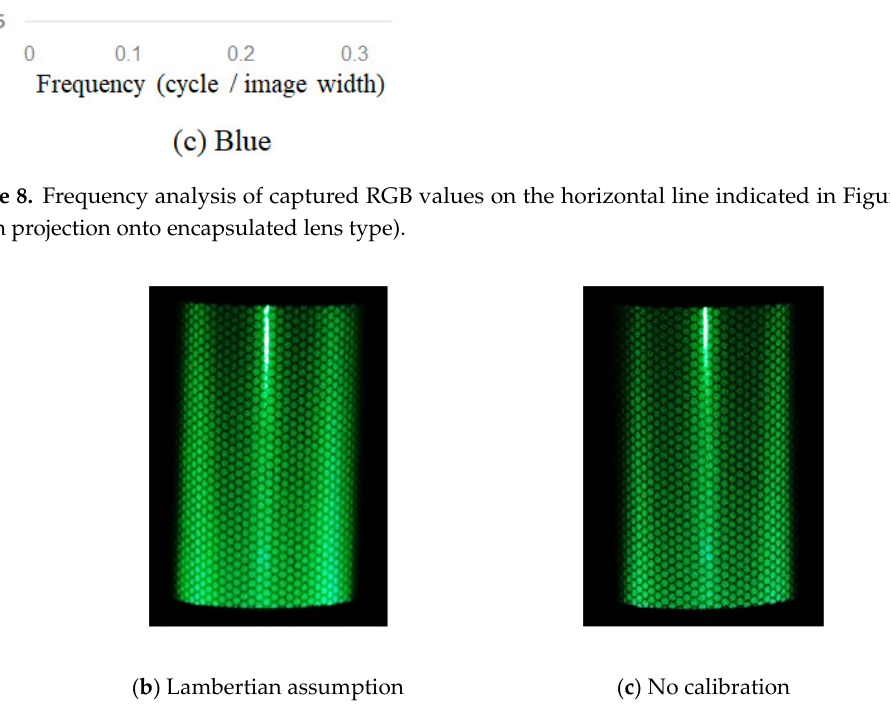
Figure 9. Comparison of visibility by green projection (encapsulated lens type).